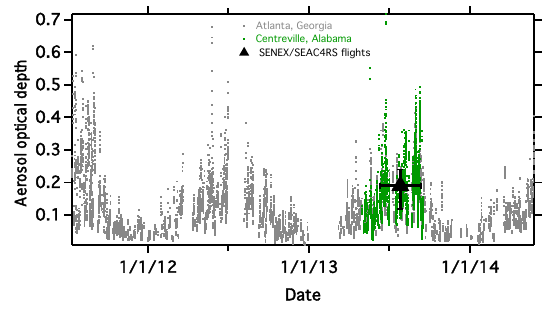
Figure 2. Atmospheric AOD measurements from the Atlanta, Geor- gia, and Centreville, Alabama, AERONET sunphotometer network sites using Level 2.0 data (Holben et al., 2001). The median and interquartile range for the SENEX and SEAC 4 RS data used in this analysis are shown by the symbol and vertical error bars, respec-